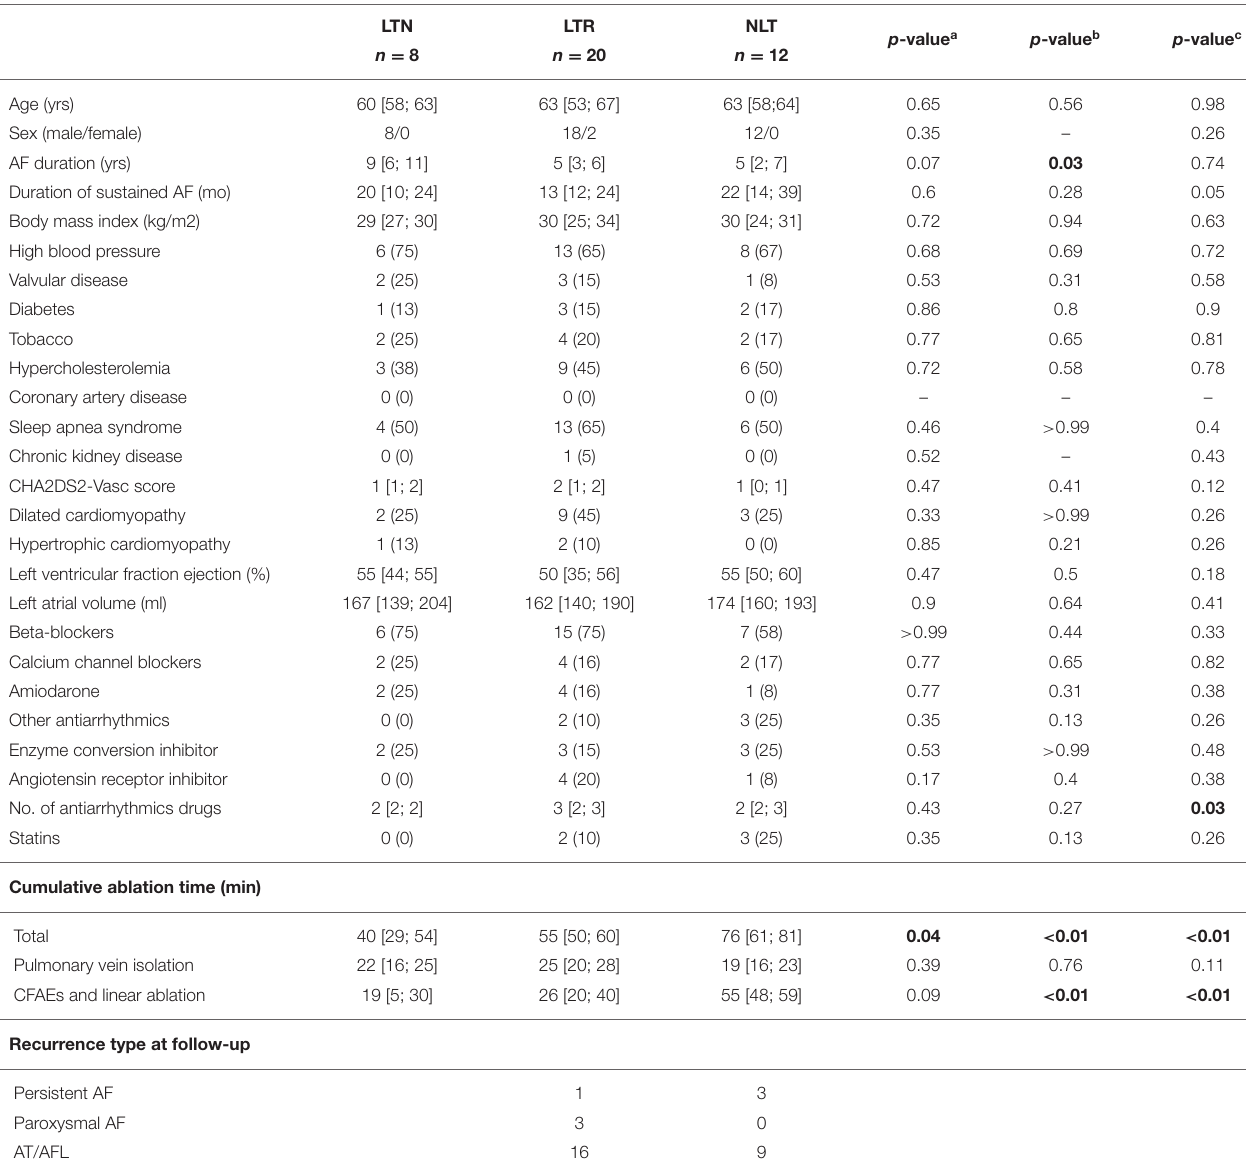
TABLE 1 | Patient clinical characteristics. Values are expressed as median with [25th; 75th] percentiles or as patient counts ( n ) and percentages of total patient